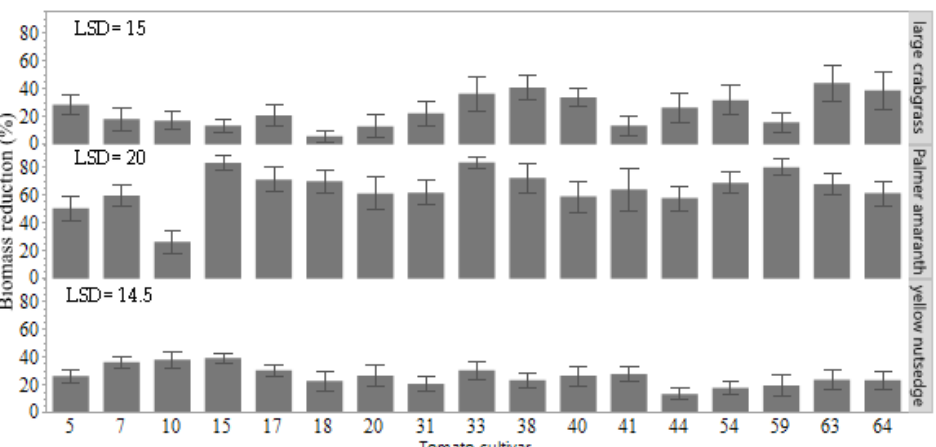
Figure 4. Weed-suppressive ability of tomato cultivars on biomass reduction (%) of Palmer amaranth, large crabgrass, and yellow nutsedge at 28 days after sowing. Four tomato plants and four plants of a single weed species were grown together in the same pot. The reduction values were based on a comparison to plants of individual weed species grown as a control treatment without tomato interference. Error bars represent the standard deviation of the mean. The difference between the two mean values is compared to the least significant difference (LSD) value. If the difference was greater than the LSD value, then the means are significantly different according to Student’s t -test at a 0.05 probability level.